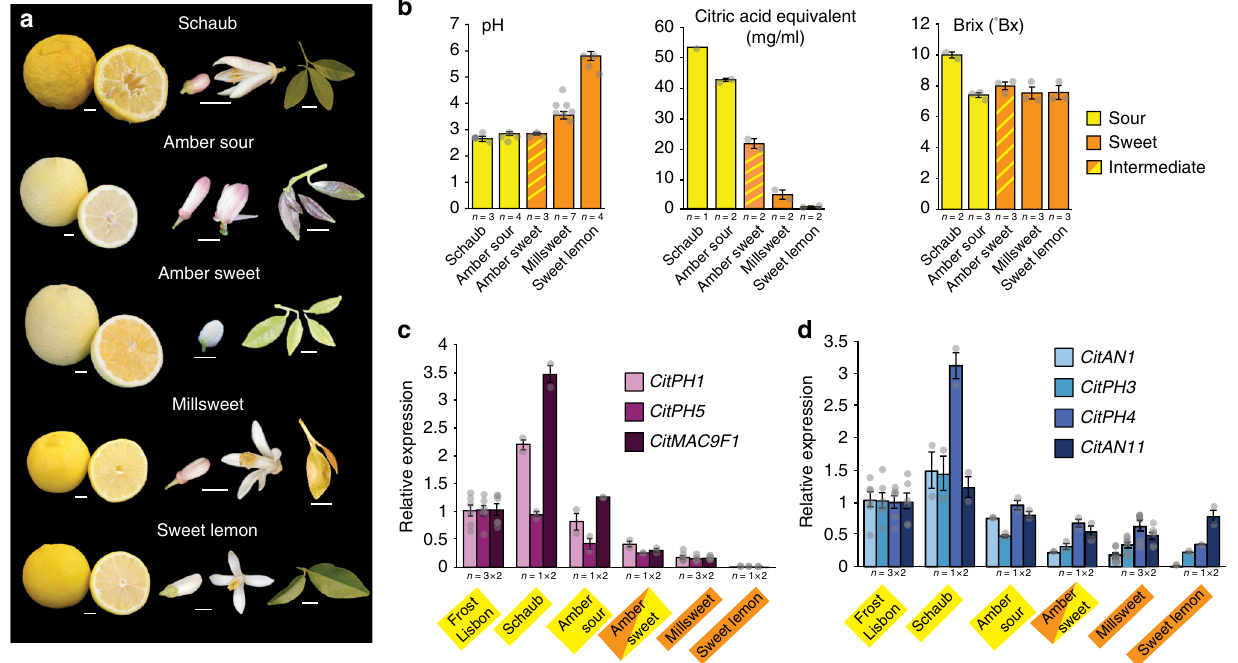
Fig. 3 Analysis of ‘ Schaub ’ , ‘ Amber ’ , ‘ Millsweet ’ , and Sweet lemon varieties. a Fruits, fl ower, and leaf phenotypes of the analyzed varieties. Size bars represent 1 cm. b pH, titratable acid, and soluble solid content (°Brix) in juice from different varieties (mean ± SE). c Real-time RT-PCR of CitPH1 , CitPH5 , and CitMAC9F1 mRNA juice vesicles. d Real-time RT-PCR of CitAN1 , CitPH3 , CitPH4 , and CitAN11 mRNA in juice vesicles. Values in c , d are mean ± SE; n = number samples from different fruits × number of technical replicates of each. For c , d , full-size nearly mature fruits were analyzed. Relative mRNA expression levels from ‘ Frost Lisbon ’ were taken from Fig. 1 and are repeated here for comparison. Source data are provided as a Source Data fi